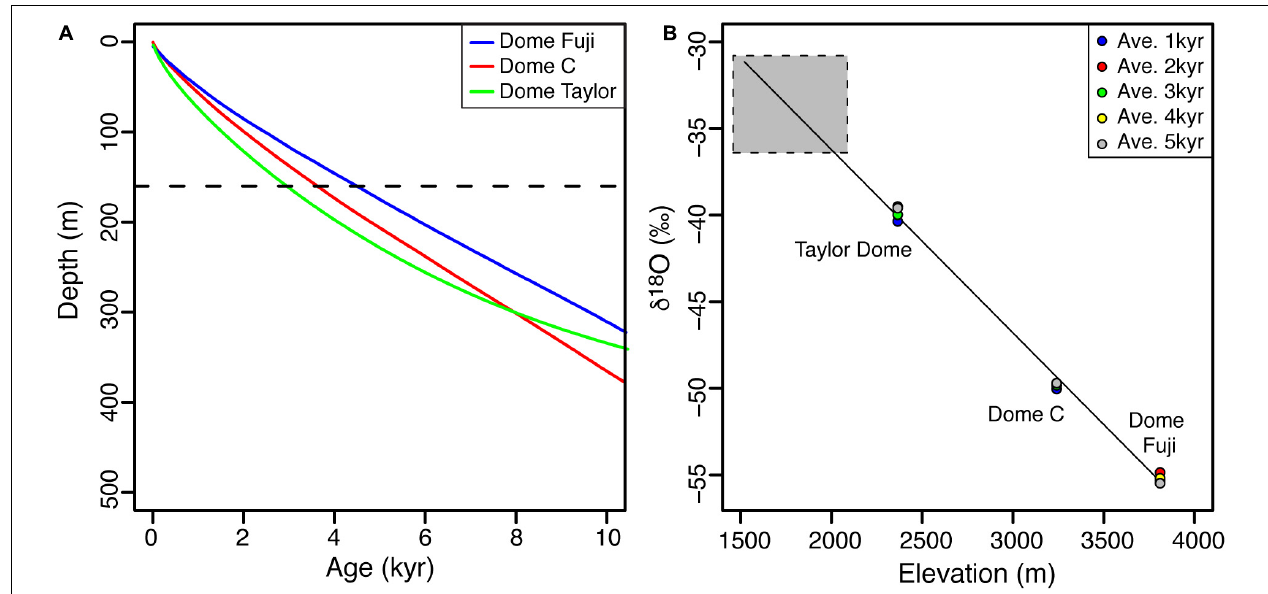
FIGURE 6 | (A) Ice cores age-depth relations for the Dome Fuji (Uemura et al., 2012), Dome C (Lorius et al., 1979) and Taylor Dome (Steig et al., 2000). The dotted line indicates the thickness of the Anuchin glacier at the lake-glacier interface (160 m). (B) δ 18 O composition of Dome Fuji (3810 m.a.s.l.), Dome C (3240 m.a.s.l.) and Taylor Dome (2365 m.a.s.l.) ice cores averaged over 1–5 ka. Gray box represents δ 18 O measurements for the Anuchin Glacier.